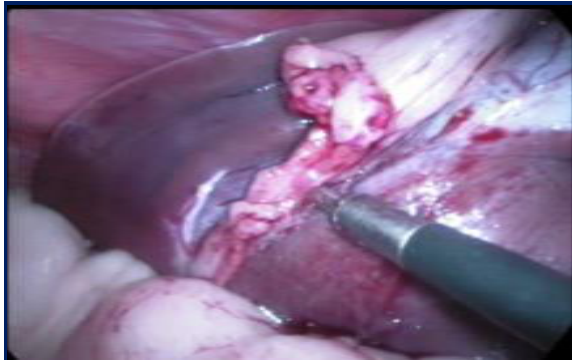
Figure, 1: Gall bladder dissection started from the neck upward, in subtotal Cholecystectomy